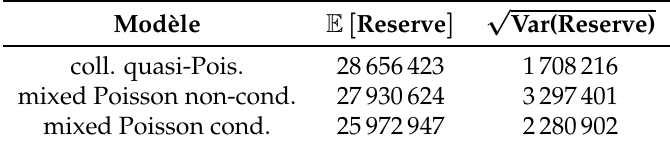
Table 4. Numerical results for θ = 10. Results for different values of θ are